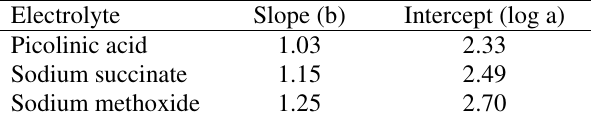
Table 2 . Parameters in eq. (1) for titanium.